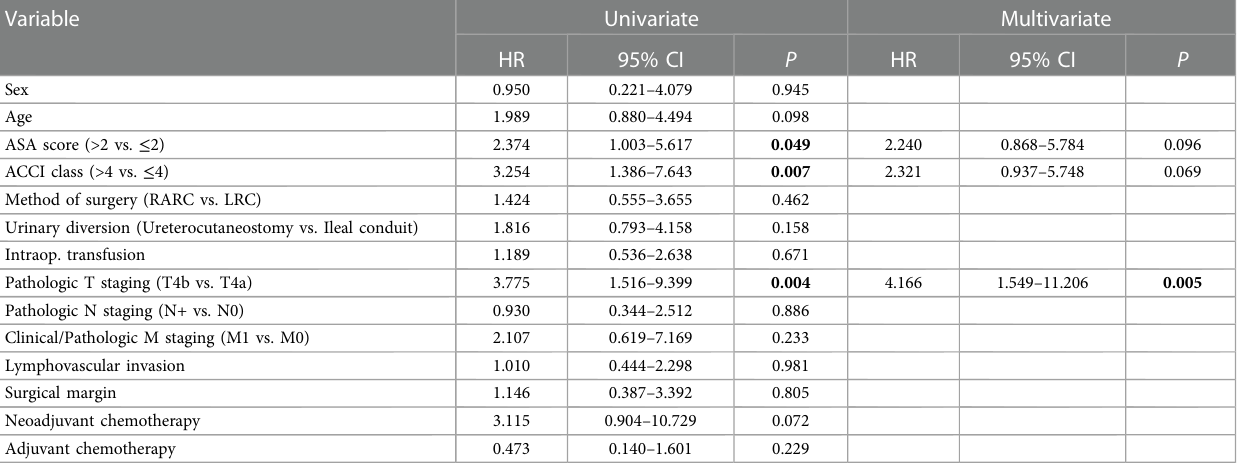
TABLE 2 Univariate and multivariate Cox proportional hazard regression analysis for